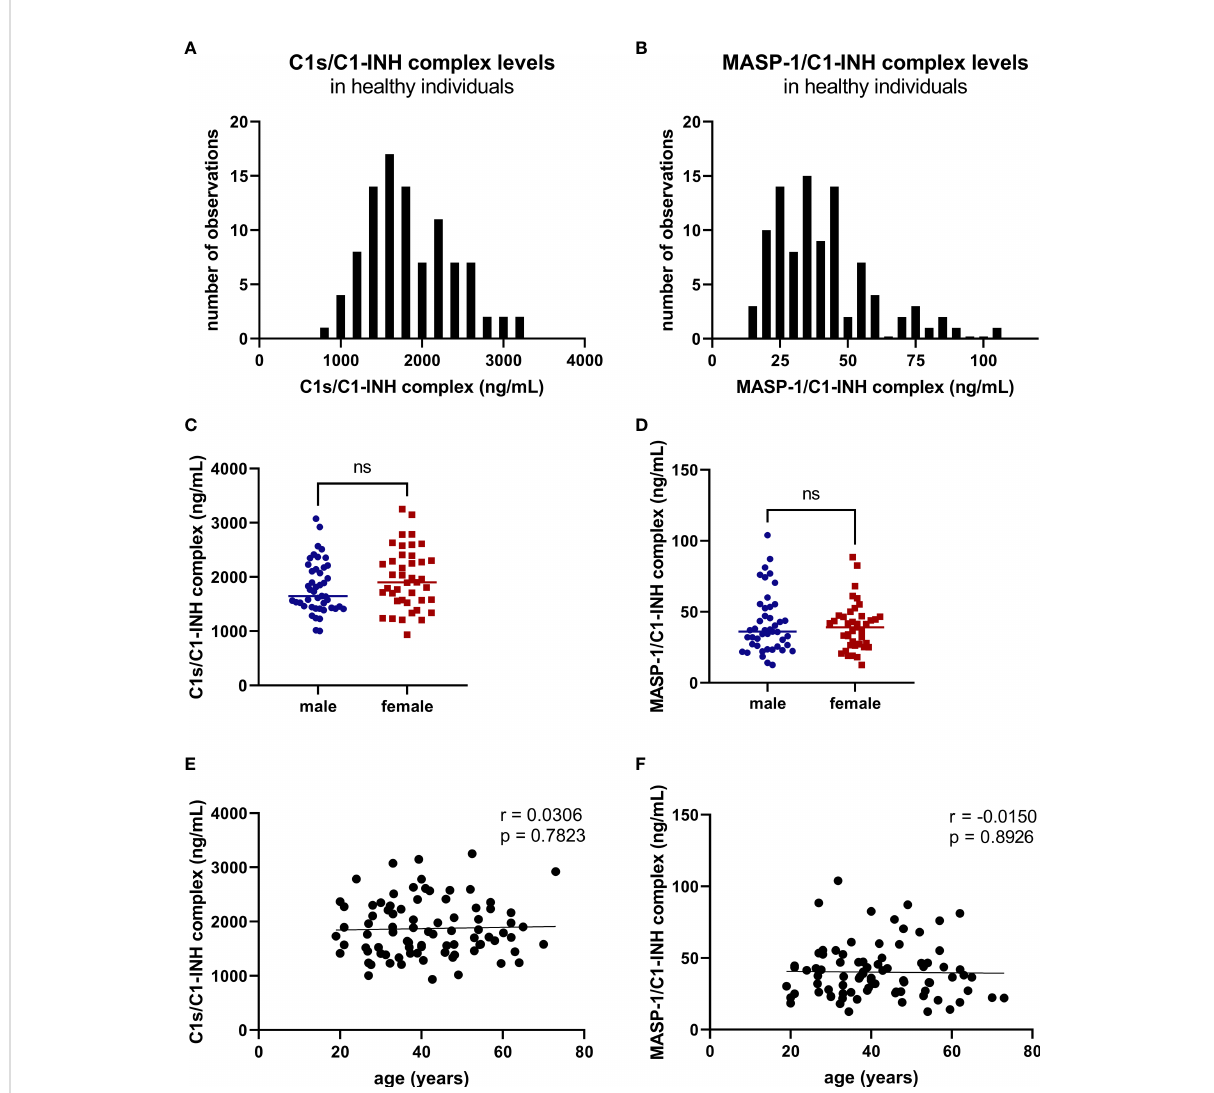
FIGURE 8 C1-INH complex levels in healthy adult individuals. C1-INH complex concentrations were measured in 96 healthy adult individuals, using the new immunoassays. Distributions of C1s/C1-INH complex (A) and MASP-1/C1-INH complex concentrations (B) are shown in histograms. Concentrations in healthy adults were furthermore strati fi ed according to gender ( C : C1s/C1-INH complex, D : MASP-1/C1-INH complex) and age ( E : C1s/C1-INH complex, F : MASP-1/C1-INH complex). No signi fi cant differences between males (n=50) and females (n=46) were observed when comparing the groups using Mann-Whitney test. ns, not signi fi cant; r, correlation coef fi